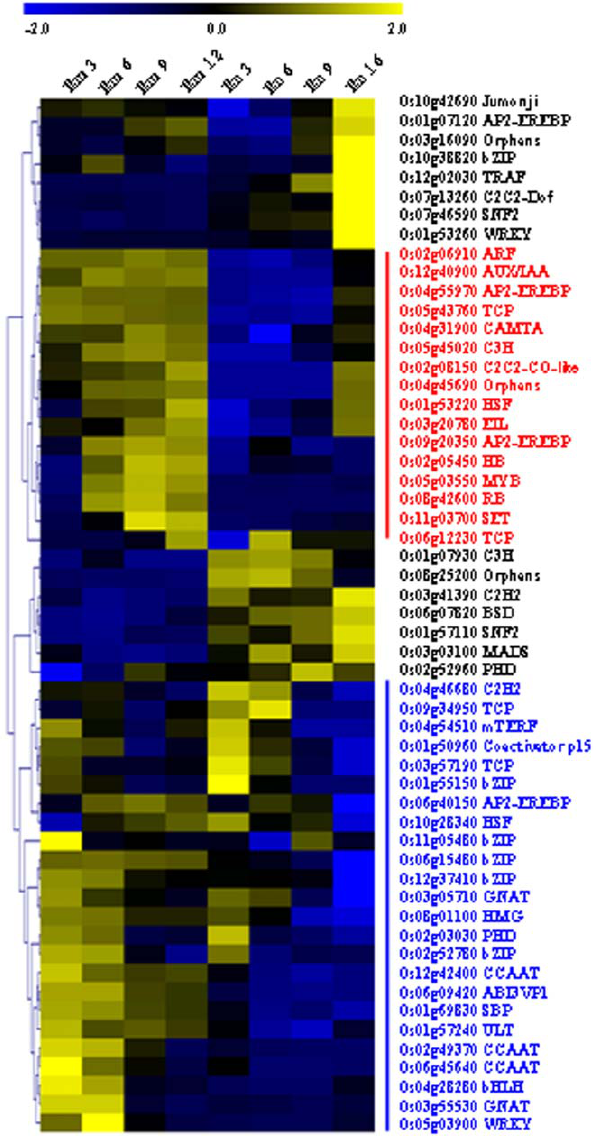
Figure 6. Expression patterns of transcription factor encoding genes during seed development. The expressions were normalized and the red or blue lines (words) indicate the up-regulated or down- regulated genes, respectively, during seed development. The scale bar was shown at the top the figure.